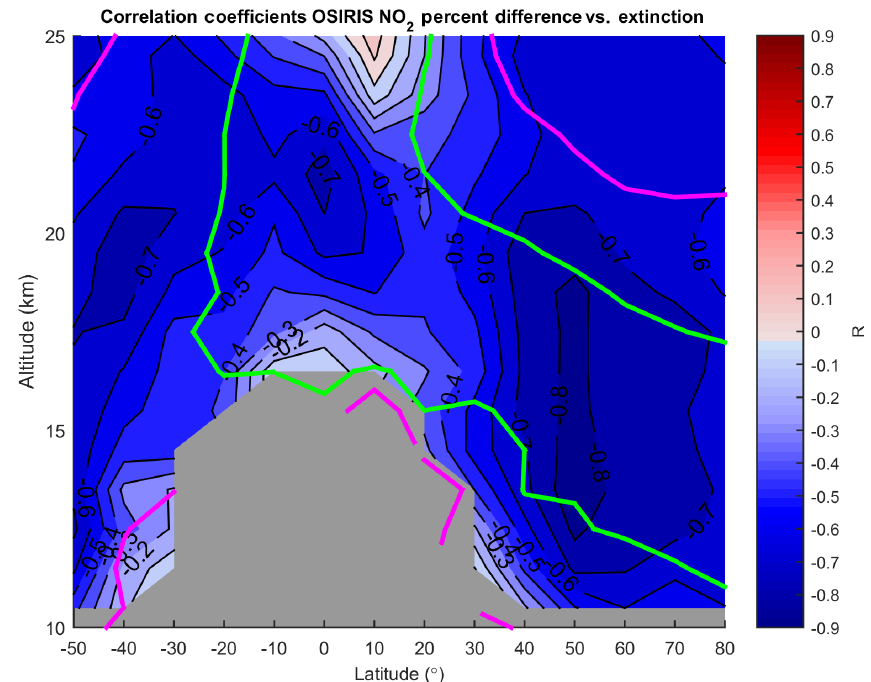
Figure 8. Correlation coefficient for time series of OSIRIS percent difference in NO 2 versus aerosol extinction for each latitude and altitude. The magenta and green contours are for latitudes and altitudes at which maximum extinction ratios over the time series were 1.2 and 2,